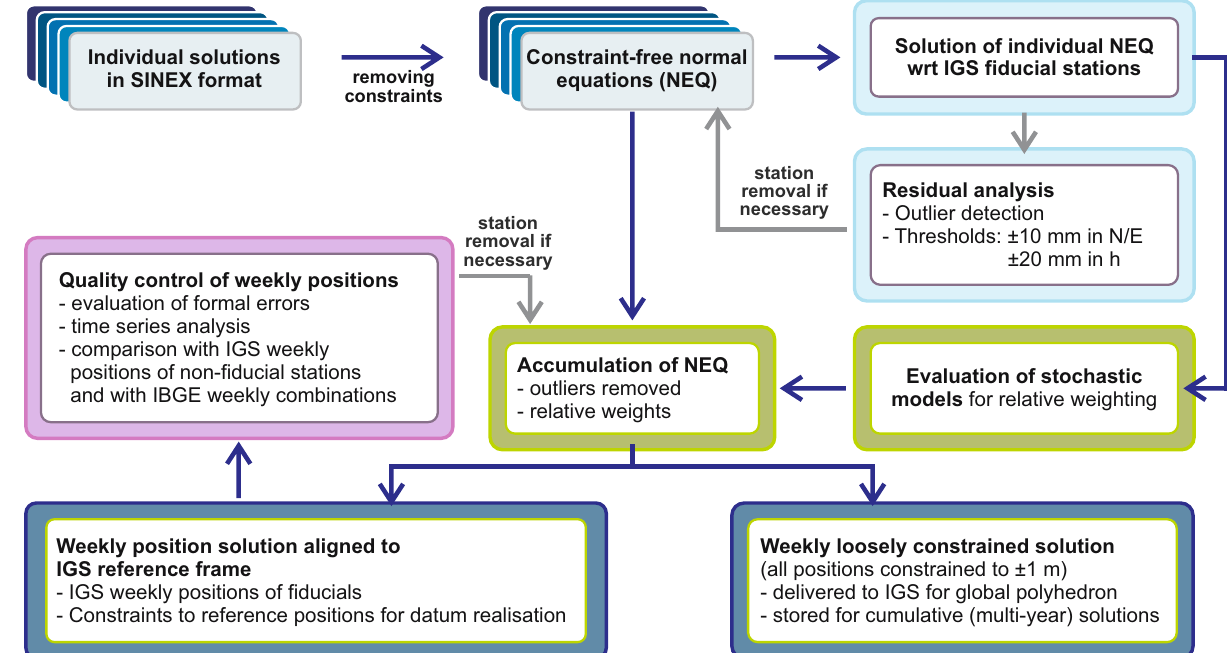
Figure 3: DGFI – TUM ’ s strategy for the combination of the SIRGAS weekly individual